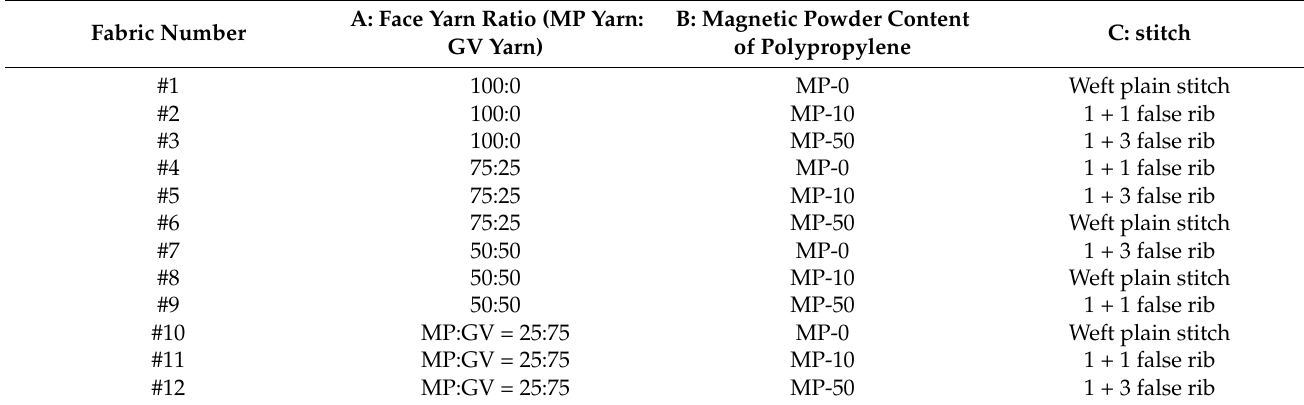
Table 3. Weaving scheme of sample